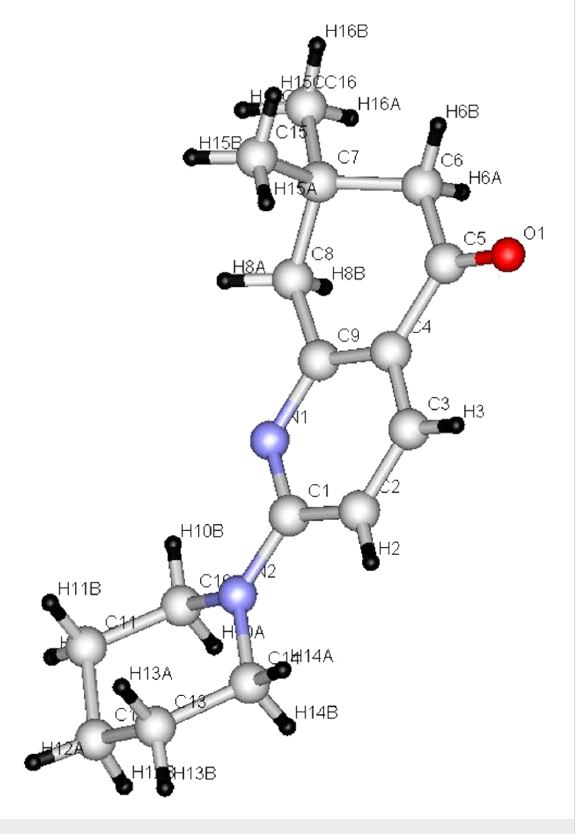
Figure 4: X-ray crystal structure of 21 .